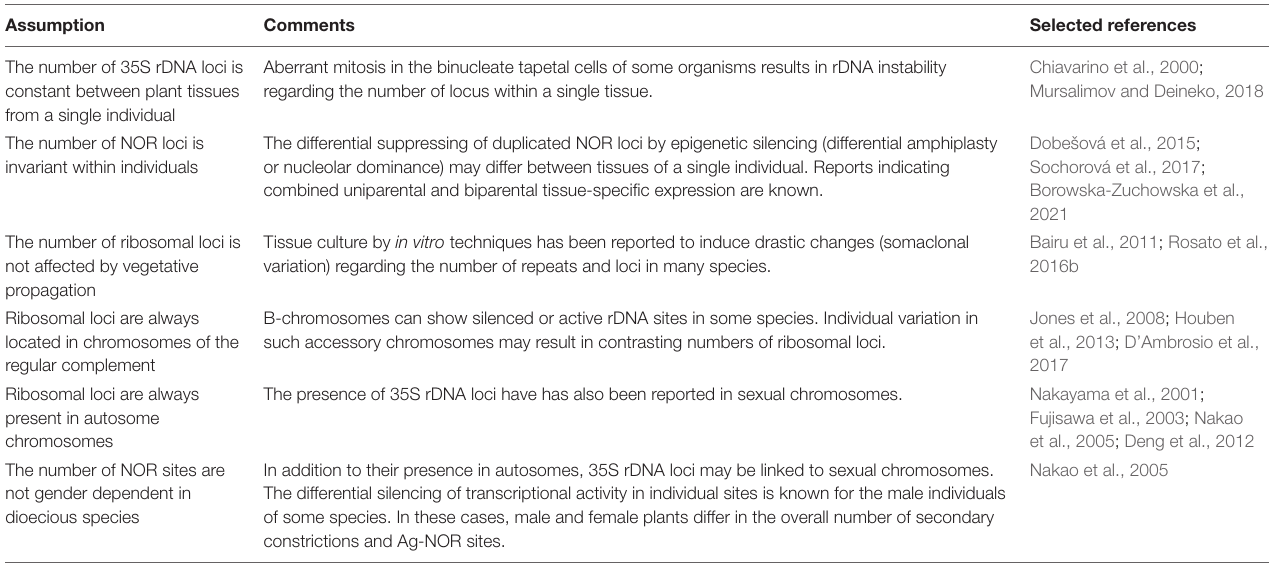
TABLE 2 | Patterns of intraindividual 35S rDNA and NOR variation in